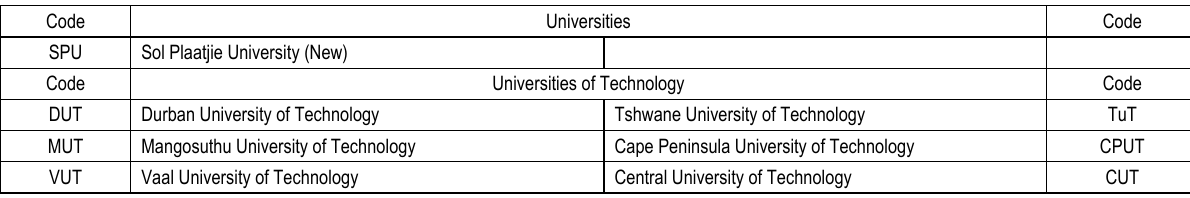
Table 1 (cont.). Universities and universities of technology in South Africa Code